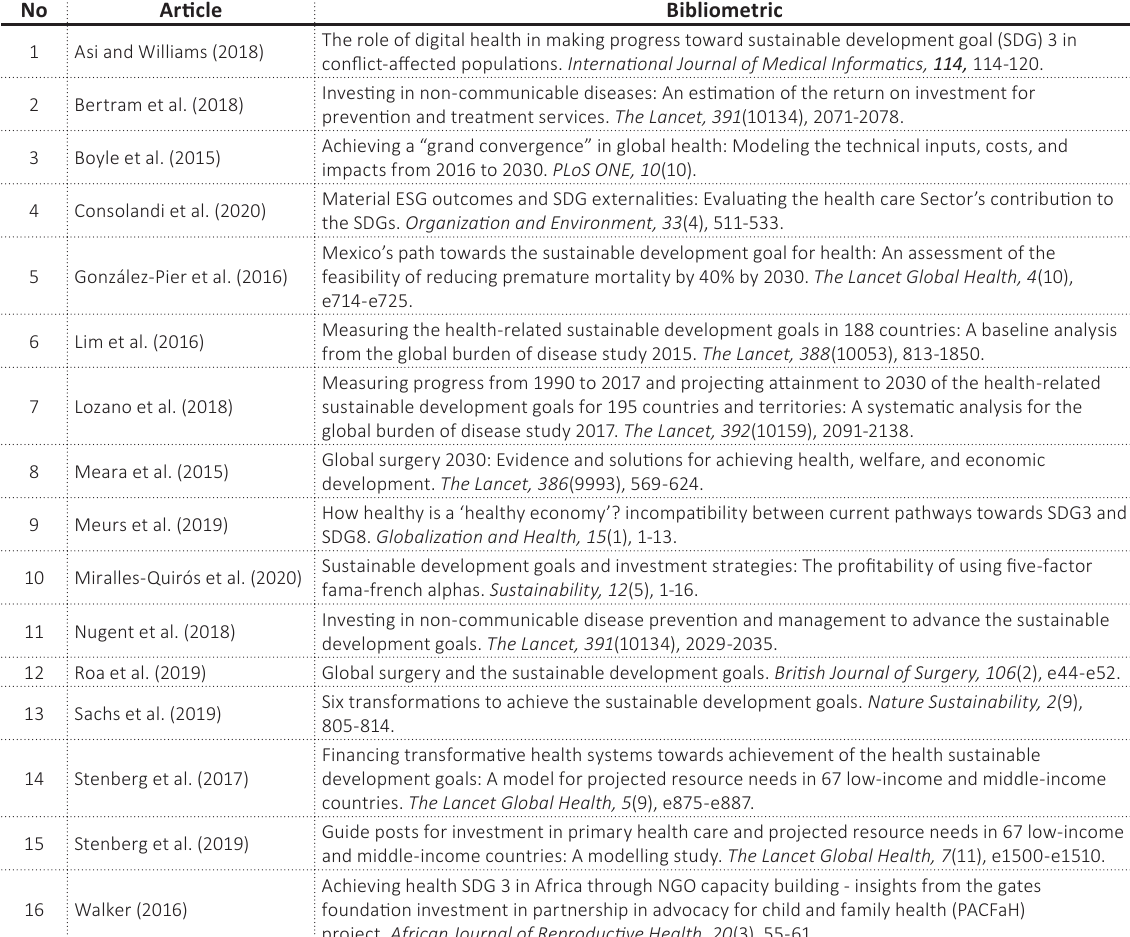
Table E1. List of articles based on the bibliometric map of publications concerning “SDG 3 and investment” and “SDG 3 and responsible